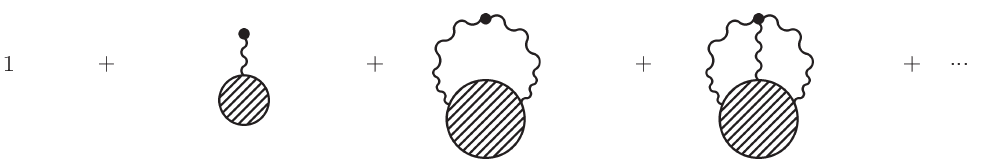
Figure 1 . Expanding H( x ) =H in powers of the graviton (cid:12)eld and then taking the expectation value results in the diagrammatic series depicted above. The spacetime point x (cid:22) is the solid vertex.